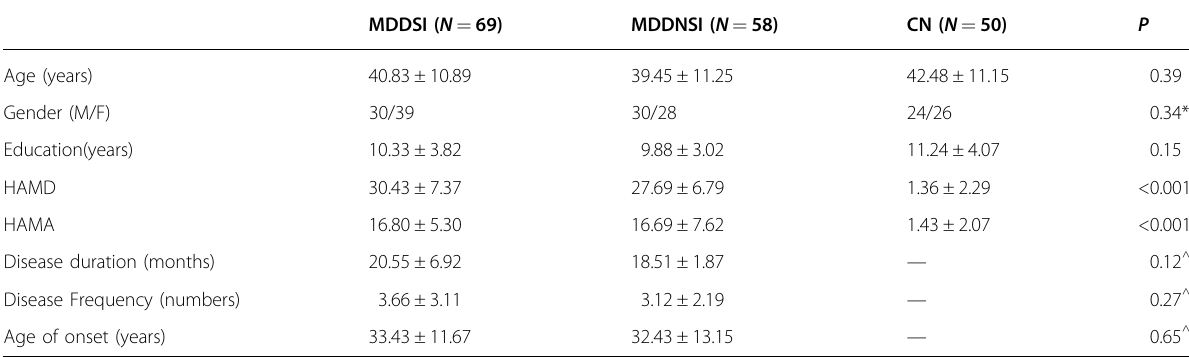
Table. 1 Demographic and clinical characteristics across all